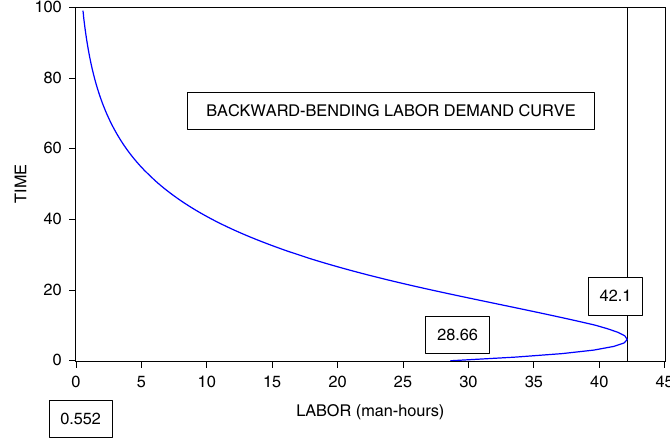
Figure 5. Backward-bending demand for labor: labor-reducing technology